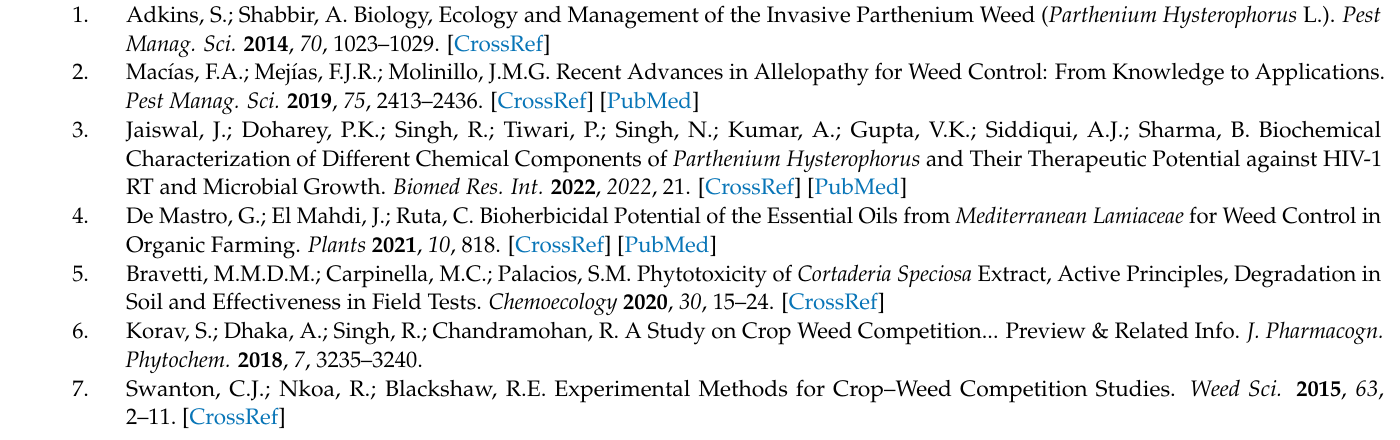
Table S3. Percent reduction in photosynthesis rate, stomatal conductance, and transpiration rate to a foliar spray of P. hysterophorus leaf extract on some crops and weeds, compared with control; Table S4. Response of malondialdehyde and proline content to a foliar spray of P. hysterophorus leaf extract on some crops and weeds; Table S5. Response of superoxide dismutase, catalase, and peroxidase activity to a foliar spray of P. hysterophorus leaf extract on some crops and